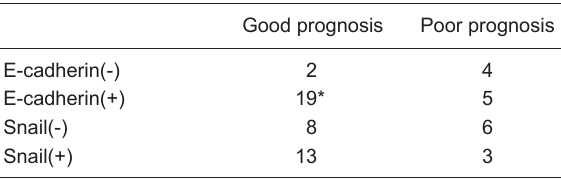
Table 4. E-cadherin and Snail immunoexpression in breast cancer specimens from patients assigned to the good and poor prognosis